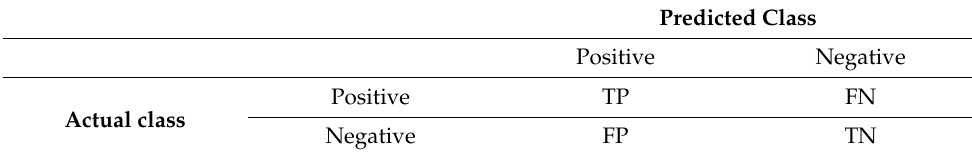
Table 6. Confusion matrix.